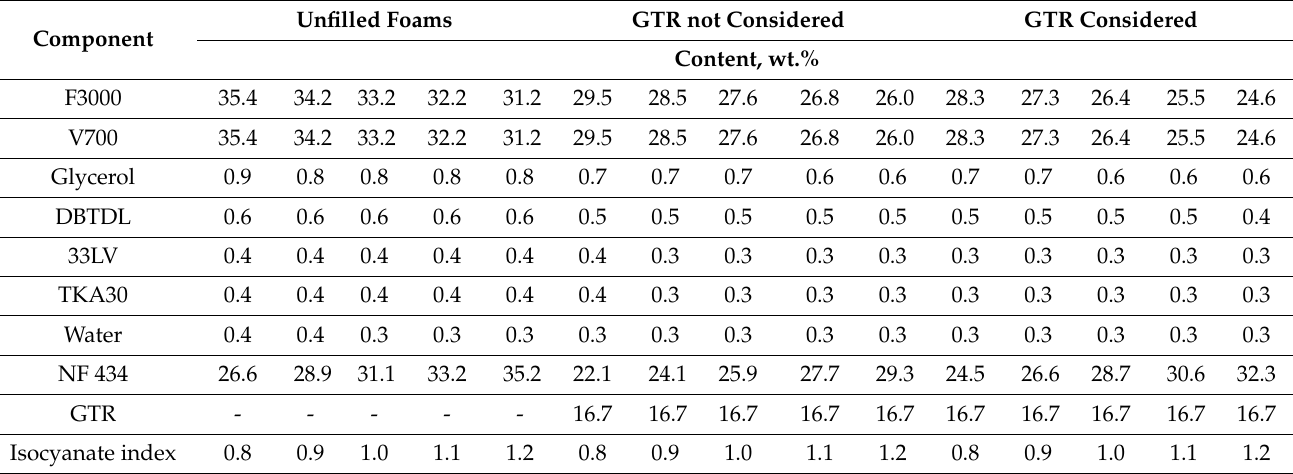
Table 1. Formulations applied during the preparation of PU